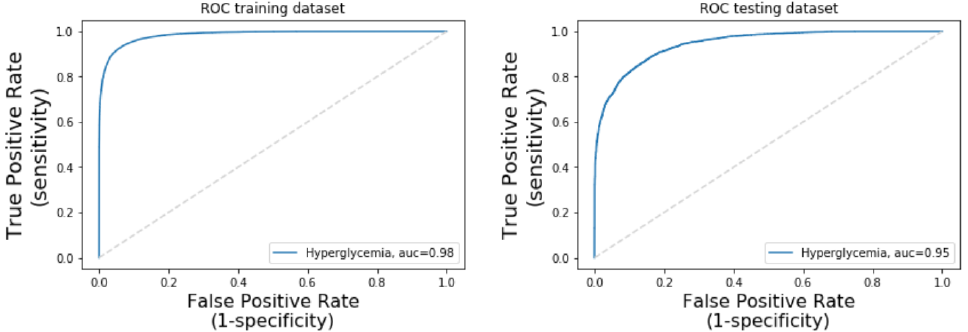
Figure 8. The 10-layer DNN ROC and AUC. A 10 k-fold cross validation was also performed in order to verify the performance consistency of the model, resulting in an average AUC of 93.65%. The AUC for each k-fold round can be seen in Table